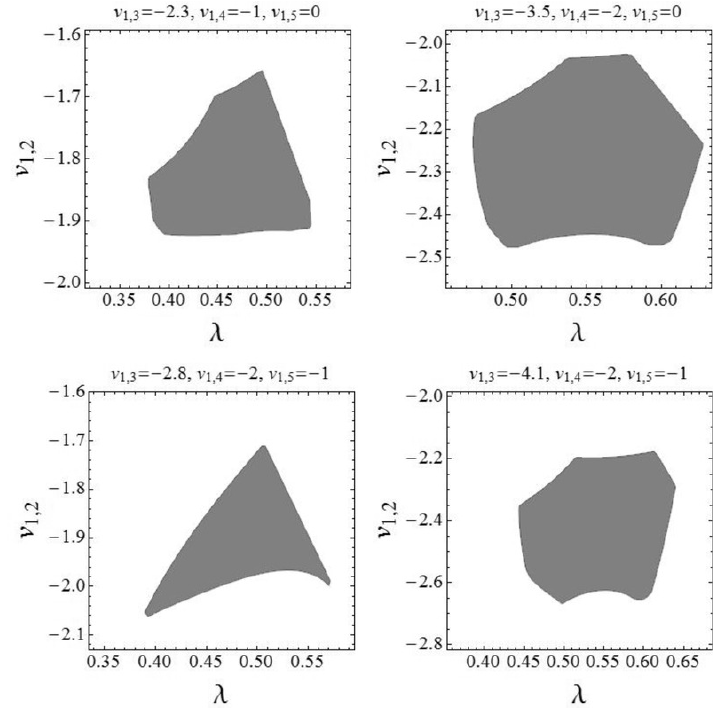
Figure 4. A - and L -stable methods of stage order q = 7 and order p =